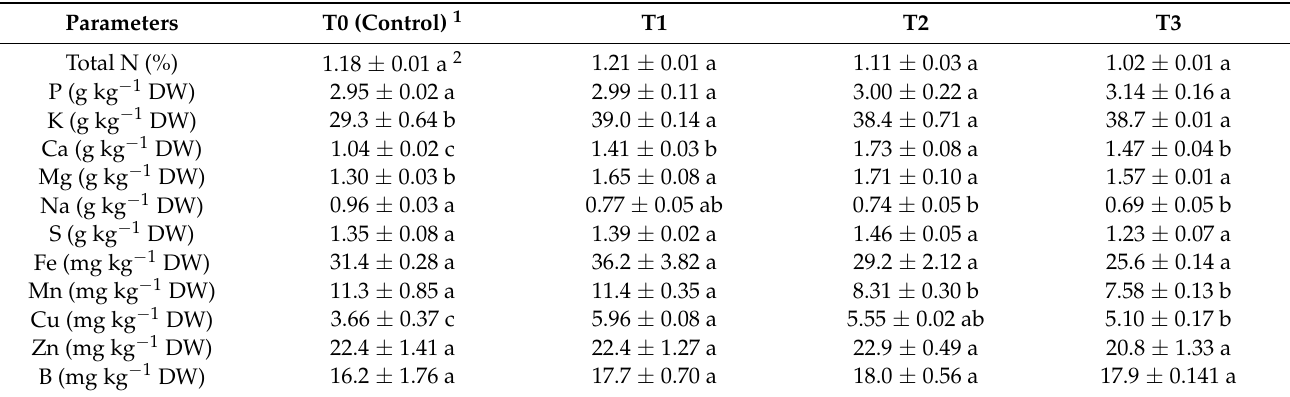
Table 9. Influence of growing media: on mineral and trace element concentrations in marketable tomato